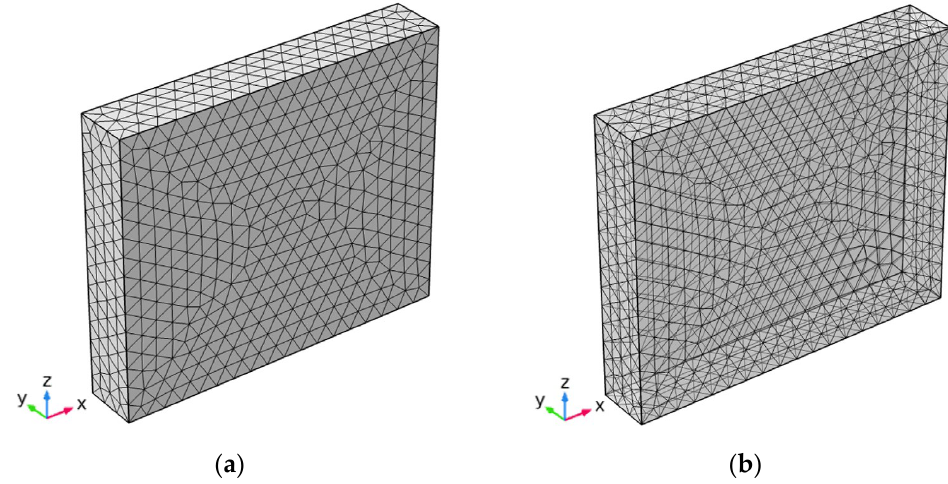
Figure 5. Construction of the finite element mesh model. ( a ) Stereogram; ( b ) Perspective.